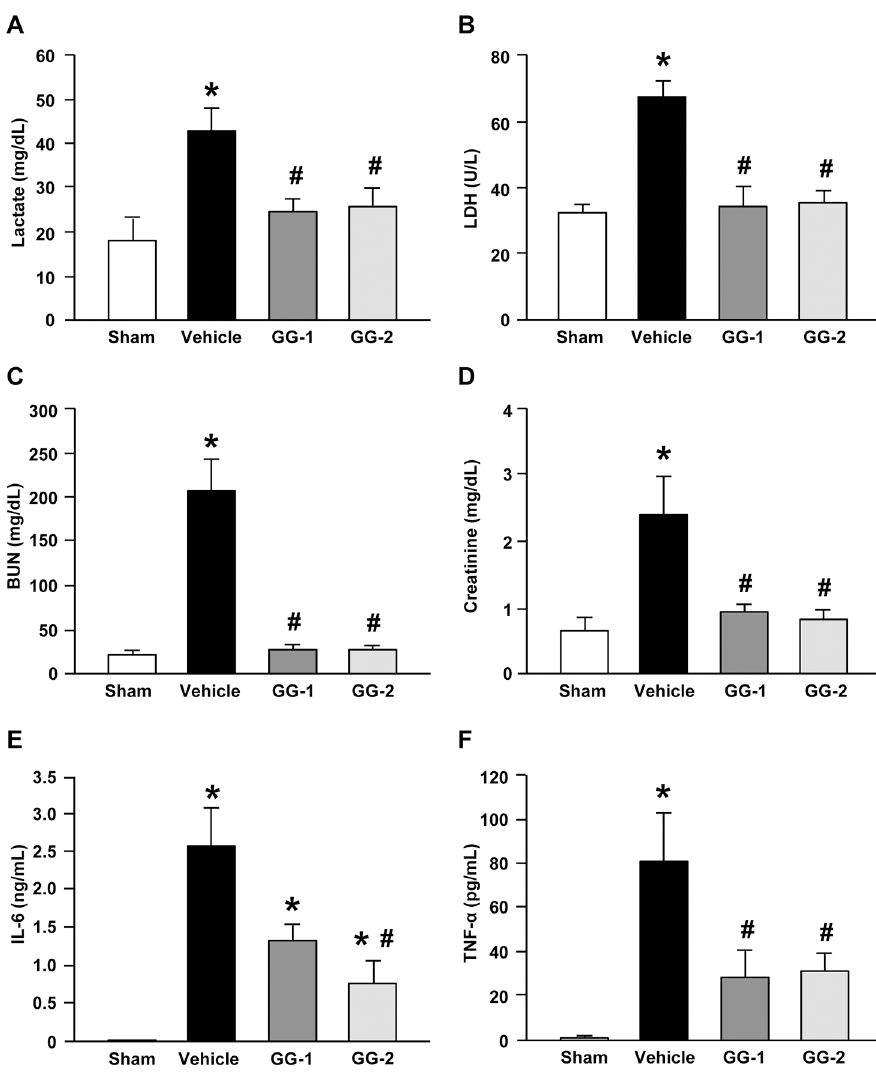
Figure 1. Effect of the combined treatment on organ injury makers and systemic inflam- mation in aged septic rats. Rats were sham operated or subjected to CLP with injection of vehicle (normal saline) or human ghrelin plus GH at two different doses, GG-1 (40 nmol/kg of ghrelin and 25 μ g/kg GH) and GG-2 (80 nmol/kg of ghrelin and 50 μ g/kg of GH) at 5 h after CLP. Blood samples were collected at 20 h after CLP for measuring (A) lactate, (B) LDH, (C) BUN, (D) creatinine, (E) IL-6 and (F) TNF- α . Data are expressed as mean ± SE (n = 5–7 per group). * P < 0.05 versus sham and # P < 0.05 versus